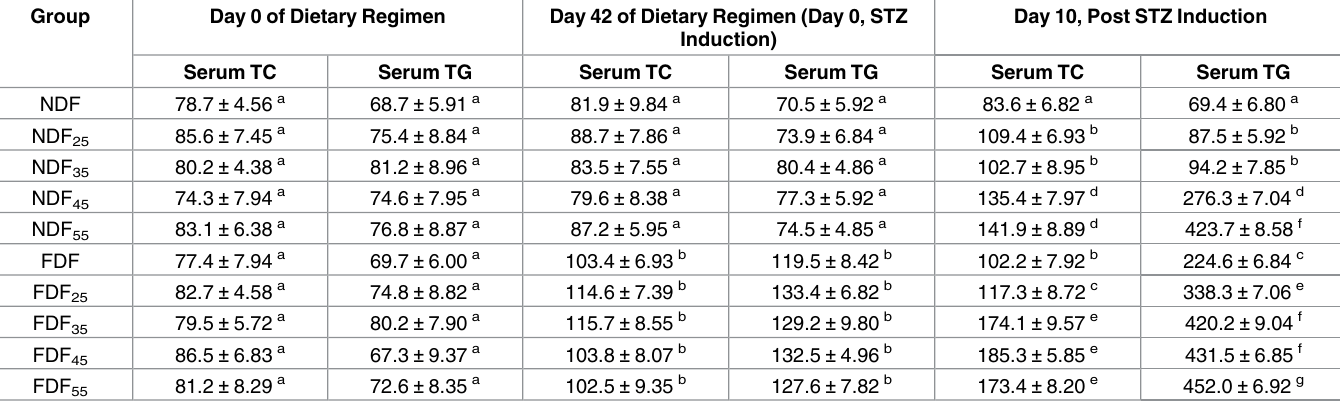
Table 3. Serum Total Cholesterol and Triglyceride in Experimental Rats.